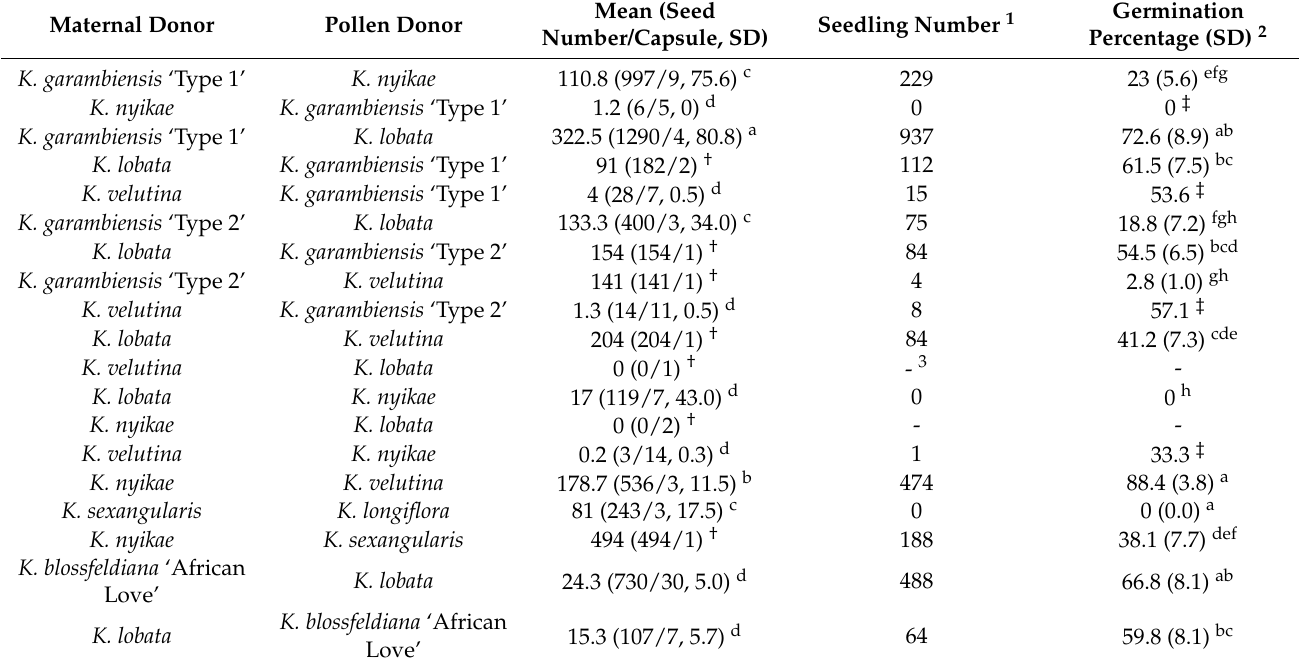
only 1.2 seeds per capsule were harvested (Table 1), suggesting that the unilateral incompat- ibility between K. garambiensis ‘Type 1’ and K. nyikae occurred from pre-fertilization to seed development. Another reciprocal cross between K. garambiensis ‘Type 2’ and K. velutina produced only 1.3 seeds per capsule when K. velutina was the maternal parent (Table 1). Notably, the seeds from this low-producing cross had higher germination (57.1%), while seeds from the normal-producing cross (141 seeds per capsule) showed low germination (2.8%) (Table 1). These results suggest that unilateral incompatibility is caused by several decouplable causes, such as pre-fertilization barriers, seed development, and seed germina- tion. Among the tested crosses, except for the combination of K. lobata and K. nyikae, which failed to obtain a hybrid, reciprocal crossing could overcome wide cross incompatibility of interspecific crosses within section Kalanchoe . Table 1. Reciprocal crossing could overcome wide cross incompatibility of interspecific crosses within the section Kalanchoe . Maternal Donor Pollen Donor